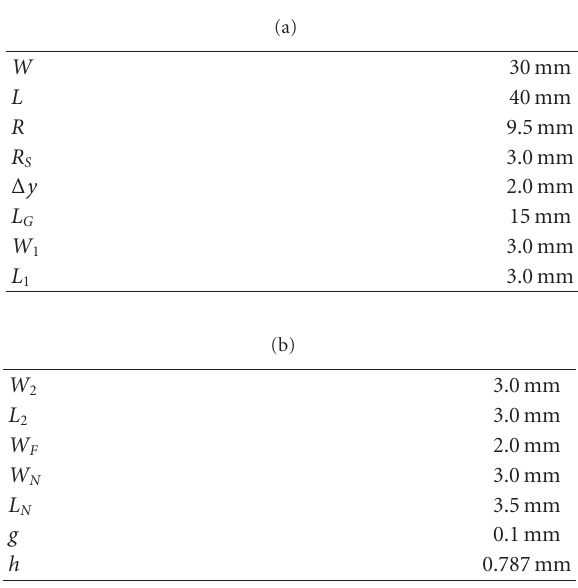
Table 1: Dimensions of the antenna element in Figure